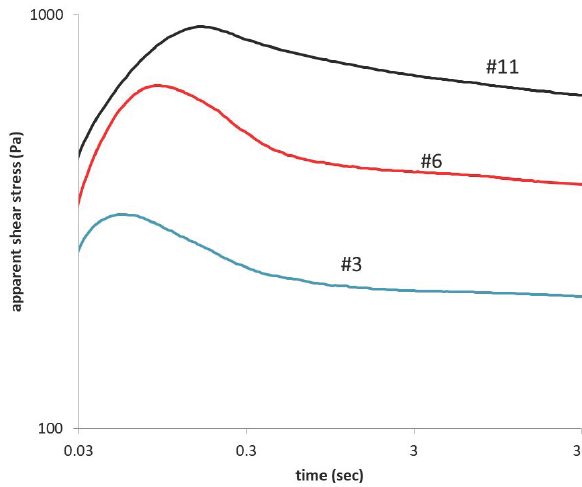
Figure 1: Transient step-shear tests for three selected samples at 30 sec −1 . The tests were performed on ARES G2 rheometer which at- tains the pre-set shear rate at or before 0.03 sec. Typical thixotropic stress overshoot is followed by a steady decline of stress as the sys- tem approaches equilibrium. As explained in the text, the reading is teaken by averaging the segment between 10 and 20